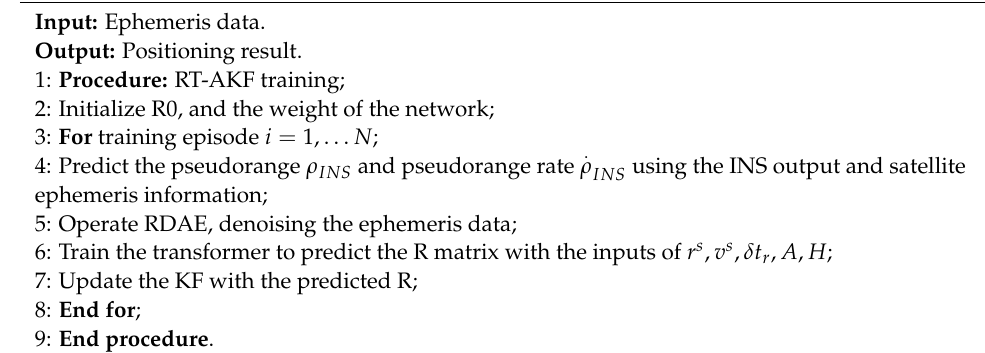
Algorithm 1: Estimation Algorithm for Measurement Noise